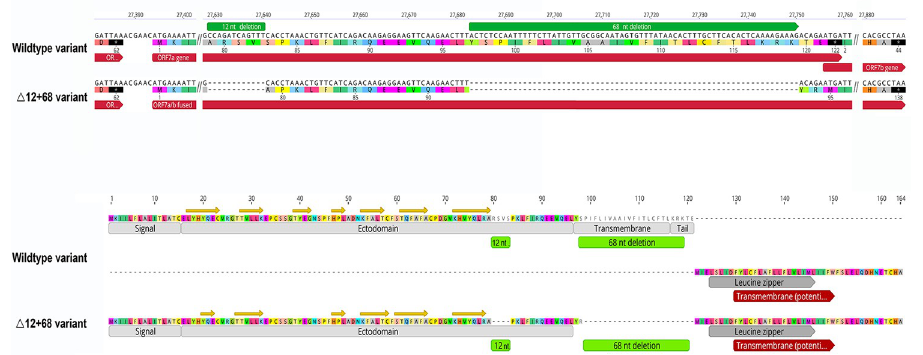
Fig 3. Top: Nucleotide and amino acid sequences of the ORF 7a/7b in wildtype and Δ 12+68 variants. Green bars show the deletion regions. Bottom: Primary structure of the 137-aa 7ab putative protein is compared with the 121-aa 7a protein of the wildtype variant. The different domains are annotated. Yellow arrows denote ß-strands.